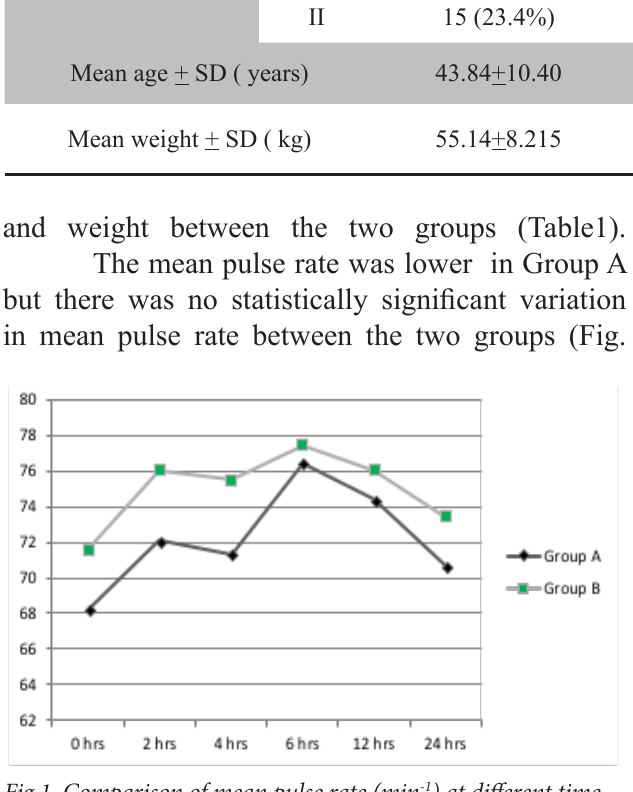
Fig 1. Comparison of mean pulse rate (min -1 ) at different time periods.